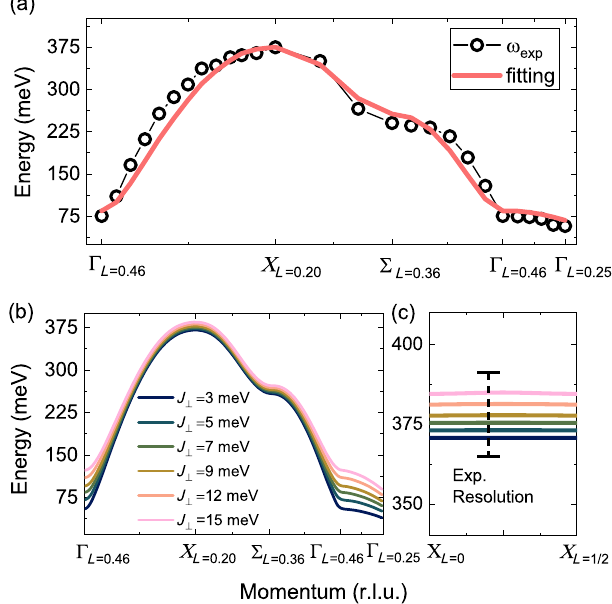
FIG. 7. Summary of fitting and simulations done with the spinW software. (a) Fitting of the experimental dispersion. The ð H; K Þ coordinates of the measured momenta are indicated by their letter as described in Sec. II, while the subscripts indicate the L value. The paths between Γ ; X ; Σ ; Γ L ¼ 0 . 46 L ¼ 0 . 20 L ¼ 0 . 36 L ¼ 0 . 46 are circumference arcs in the H – L plane, while the last segment is a straight line. (b) Calculated dispersion along the same path for different J ⊥ values. (c) Calculated L dependence at the X point for the same J ⊥ values as in panel (b). The black dotted line is our best experimental resolution (26